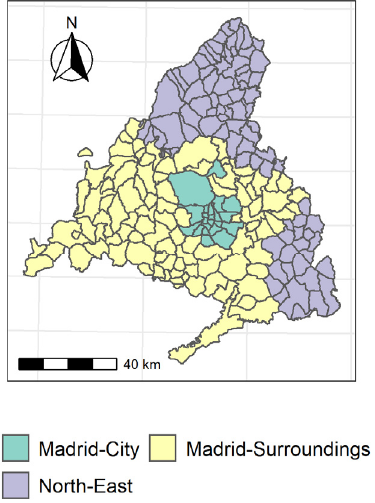
Figure 1. Cluster with components.